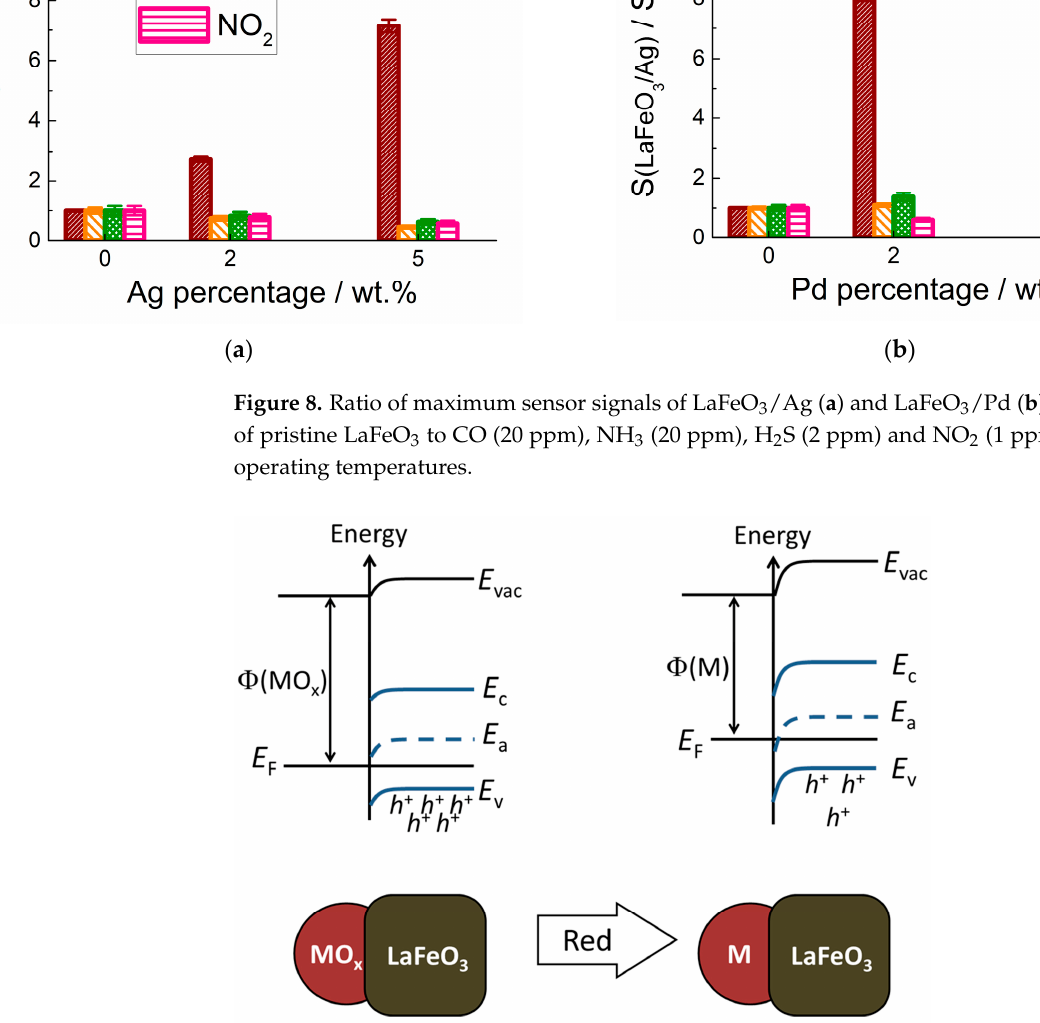
Figure 9. Scheme of electronic sensitization effect of LaFeO 3 by partially oxidized noble metals, where MO x is Ag 2 O/Ag or PdO/Pd, M is one of the reduced noble metals, E vac is vacuum level, E c is conduction band edge, E a is acceptor level, E v is valence band edge, and Φ is work function of oxidized and reduced noble metals.